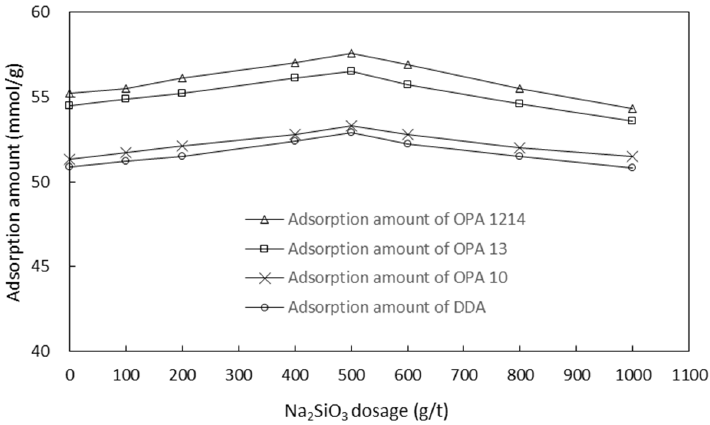
Figure 9. Adsorption amount of each collector on smithsonite particles at different Na 2 SiO 3 concen ‐ trations (Na 2 S of 6000 g/t).